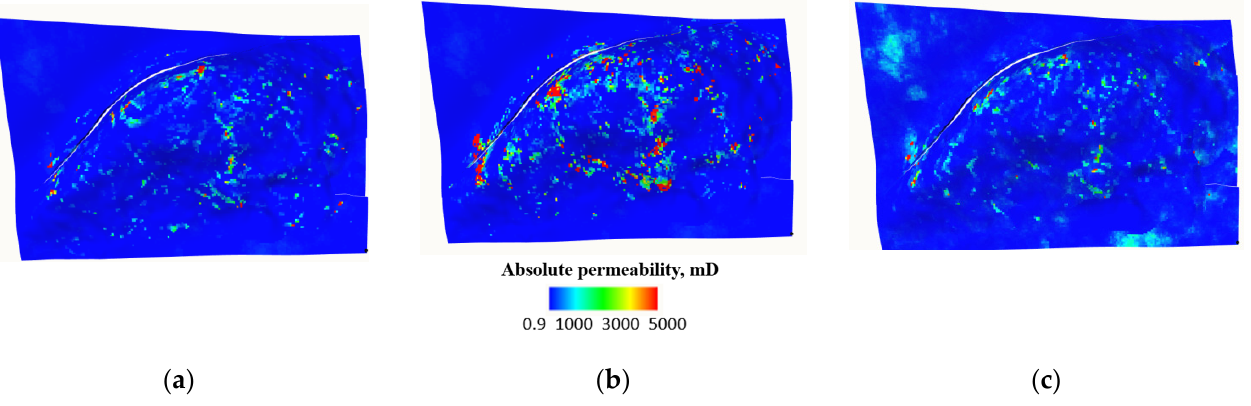
Figure 4. Permeability arrays (plane view): ( a ) X-direction, ( b ) Y-direction, ( c ) Z-direction.